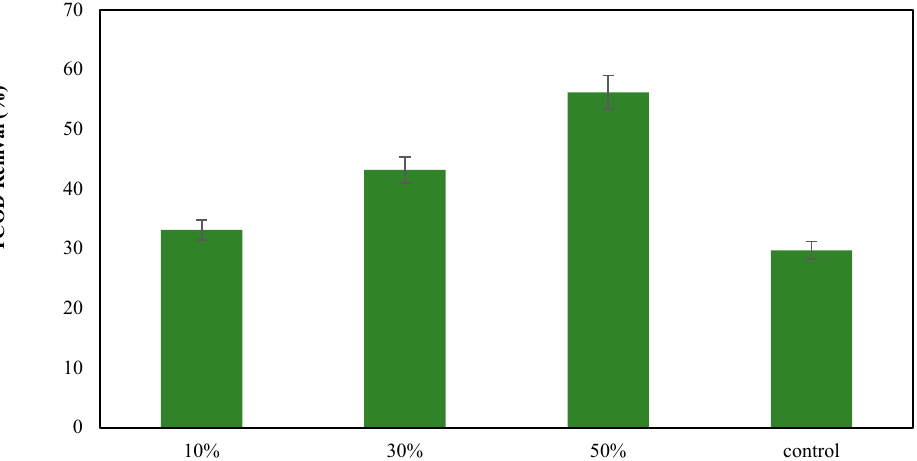
Figure 10. Total TCOD removable found from each digester after 14 days of digestion with HRT = 20, T = 37 °C.